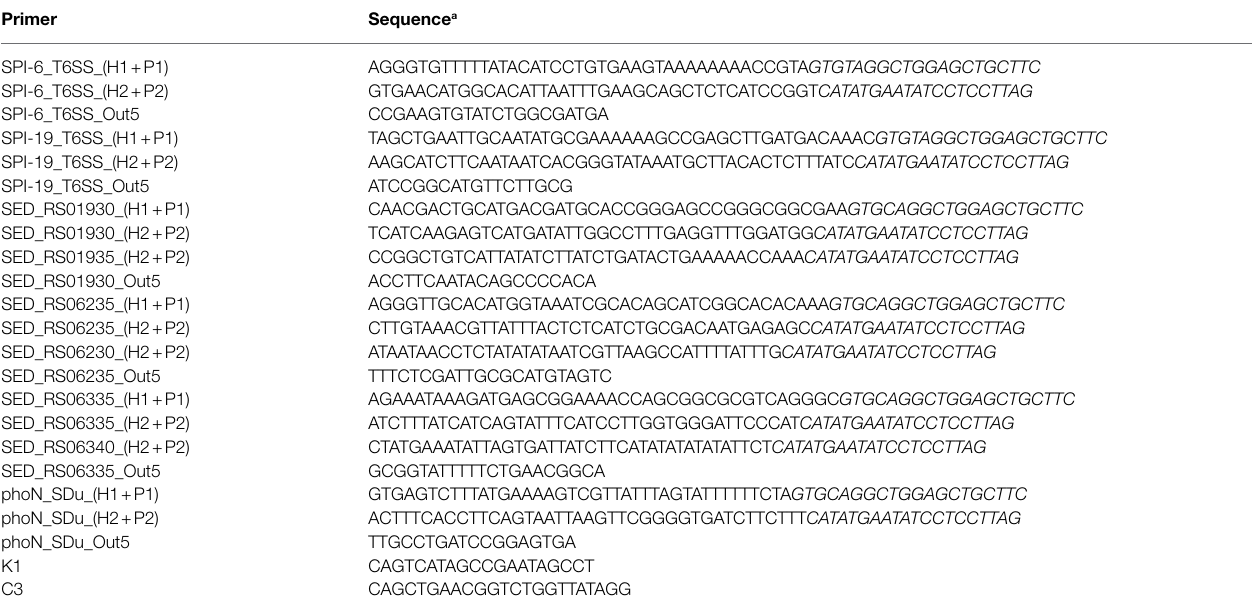
TABLE 2 | Primers used in this